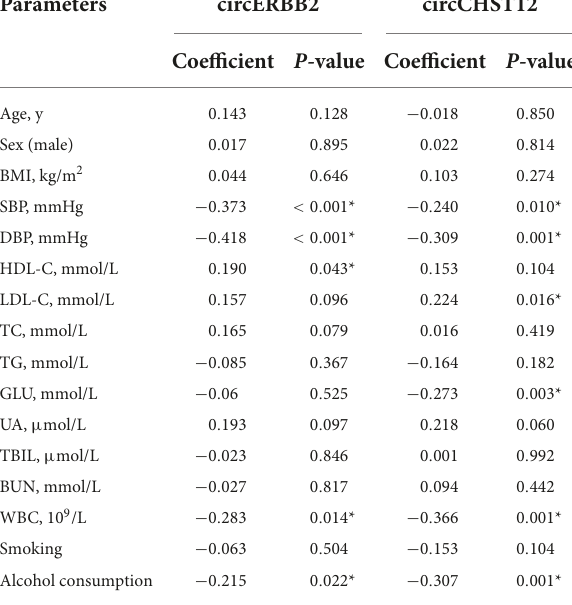
TABLE 5 Correlation between baseline characteristic and circRNA levels in intracerebral hemorrhage (ICH) patients.